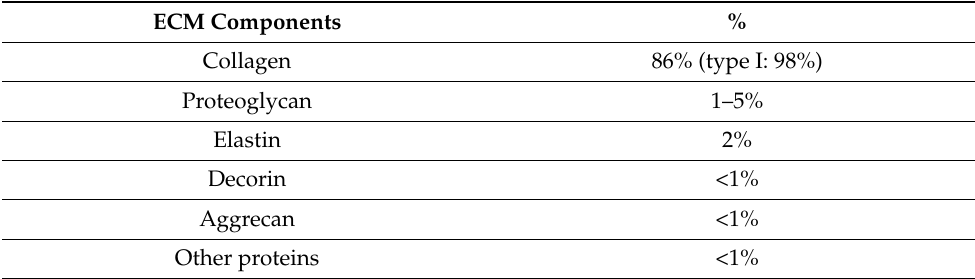
Figure 1. ( A ) Type I collagen in tenocytes, harvested from degenerated human supraspinatus tendon, stimulated for 14 days with 1000 μg/mL (>500 KDa) of HA; ( B ) untreated cells. Table 1. ECM components of tendons.